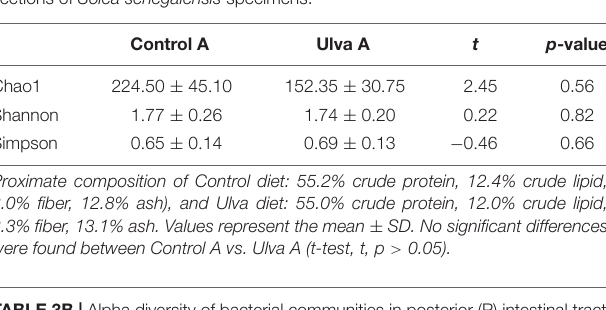
TABLE 3A | Alpha diversity of bacterial communities in anterior (A) intestinal tract sections of Solea senegalensis